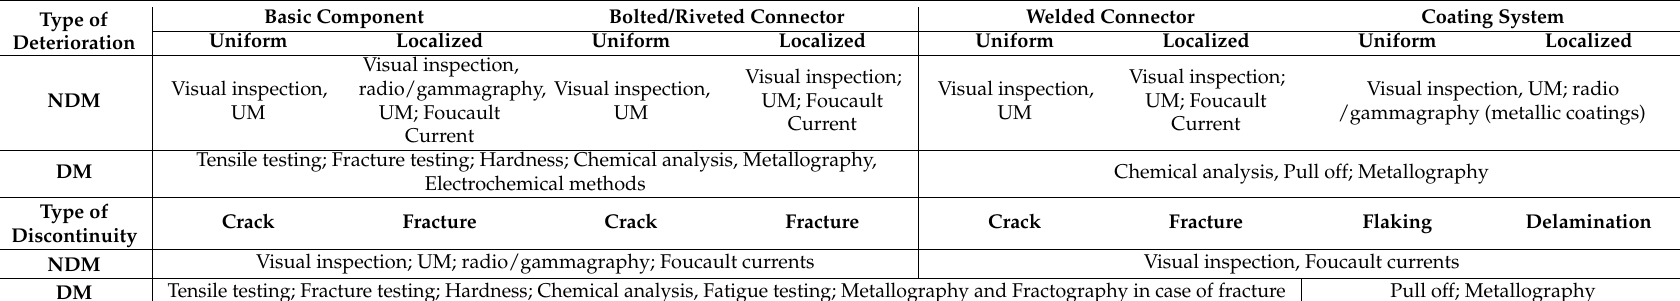
Table 14. Adequacy of each non-destructive methods (NDM) and destructive methods (DM) according to the defects (deterioration and